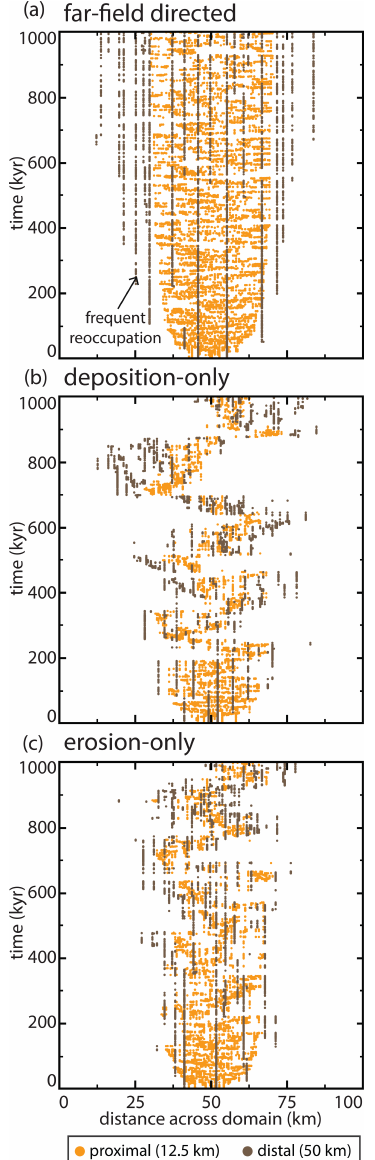
Figure 7. Active channel position histories over 1Myr at two dis- tances from the mountain front for three runs. Distances to the mountain front are illustrated via horizontal bars in Figs. 6a and Fig. 12a. In each run, only one channel position is possible per time step. (a) A run using the same parameters as Fig. 6. Note frequent and continued reoccupation for distal river positions. Panels (b) and (c) show runs identical to those in panel (a) , except the healing modes are deposition-only and erosion-only, respectively (Fig. 12a). These runs show similar behavior to that in panel (a) in early years but transition to lobe-switching